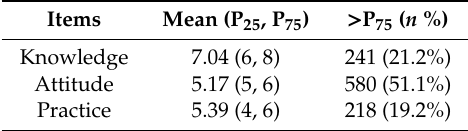
Table 2. Knowledge, attitude and practice scores and classifications among